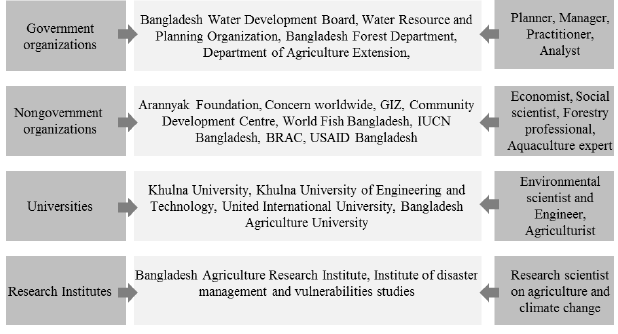
Fig. 2 . Categories of key informants from different organizations and institutes.